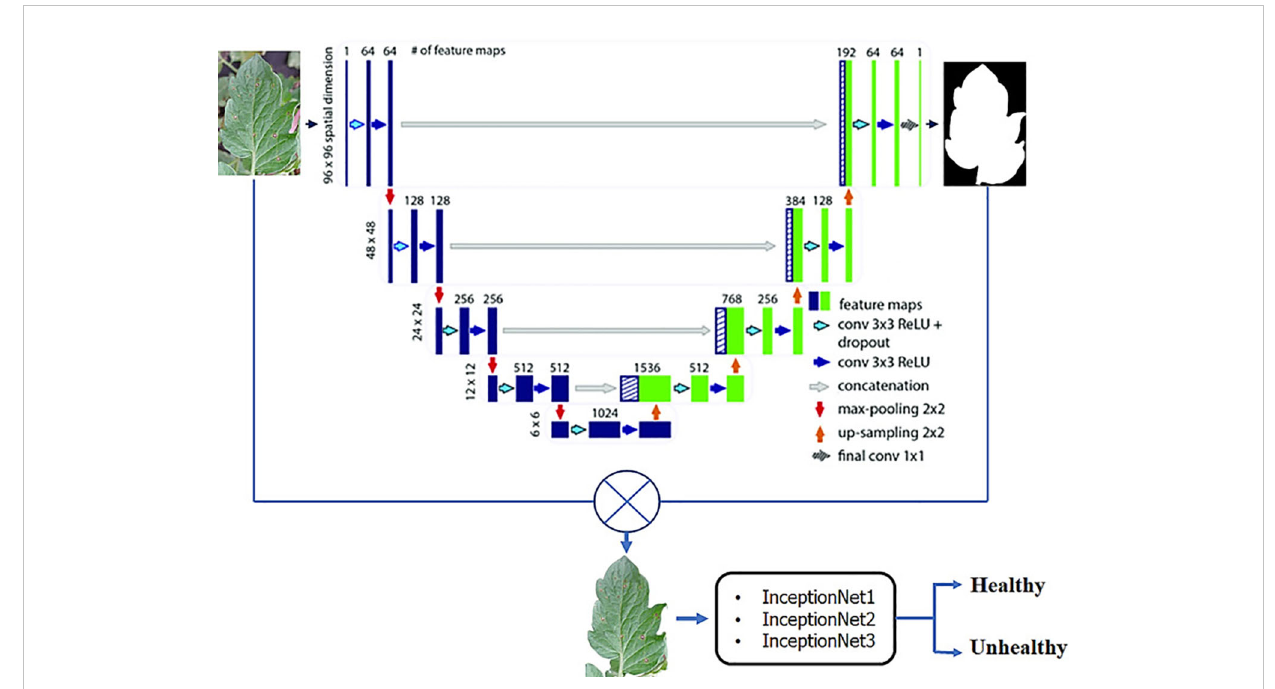
FIGURE 2 A CNN framework for classifying plants into healthy and unhealthy (Shoaib et al.,